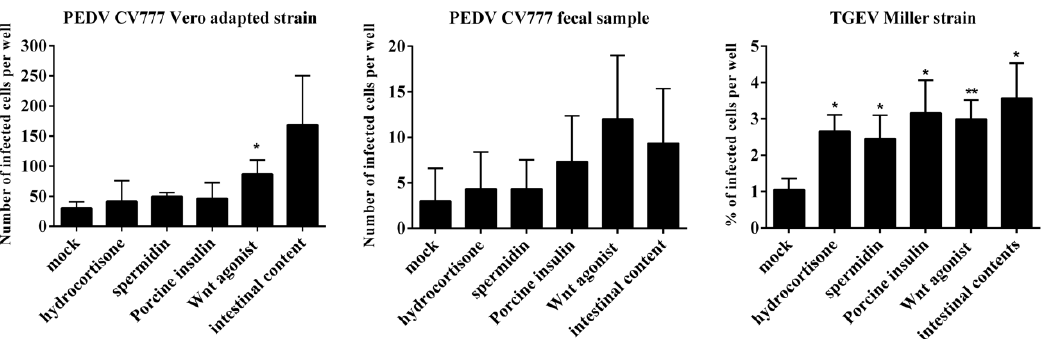
Figure 3. Infectivity of enterocytes to PEDV and TGEV after 24 h treatment with hydrocortisone, spermidine, porcine insulin, Wnt agonist, or small intestinal contents. Enterocytes were cultured with hydrocortisone, spermidine, porcine insulin, Wnt agonist or small intestinal contents. Twenty-four hours post cultivation, cells were inoculated with PEDV and TGEV. The level of infection was measured as number of infected cells per well (PEDV) or percentage of infected cells (TGEV) by immunofluorescence. Data are expressed as mean ± SD of the results of three separate experiments. Statistically significant differences in comparison with data from mock treatment are presented as * p < 0.05 or ** p < 0.01.